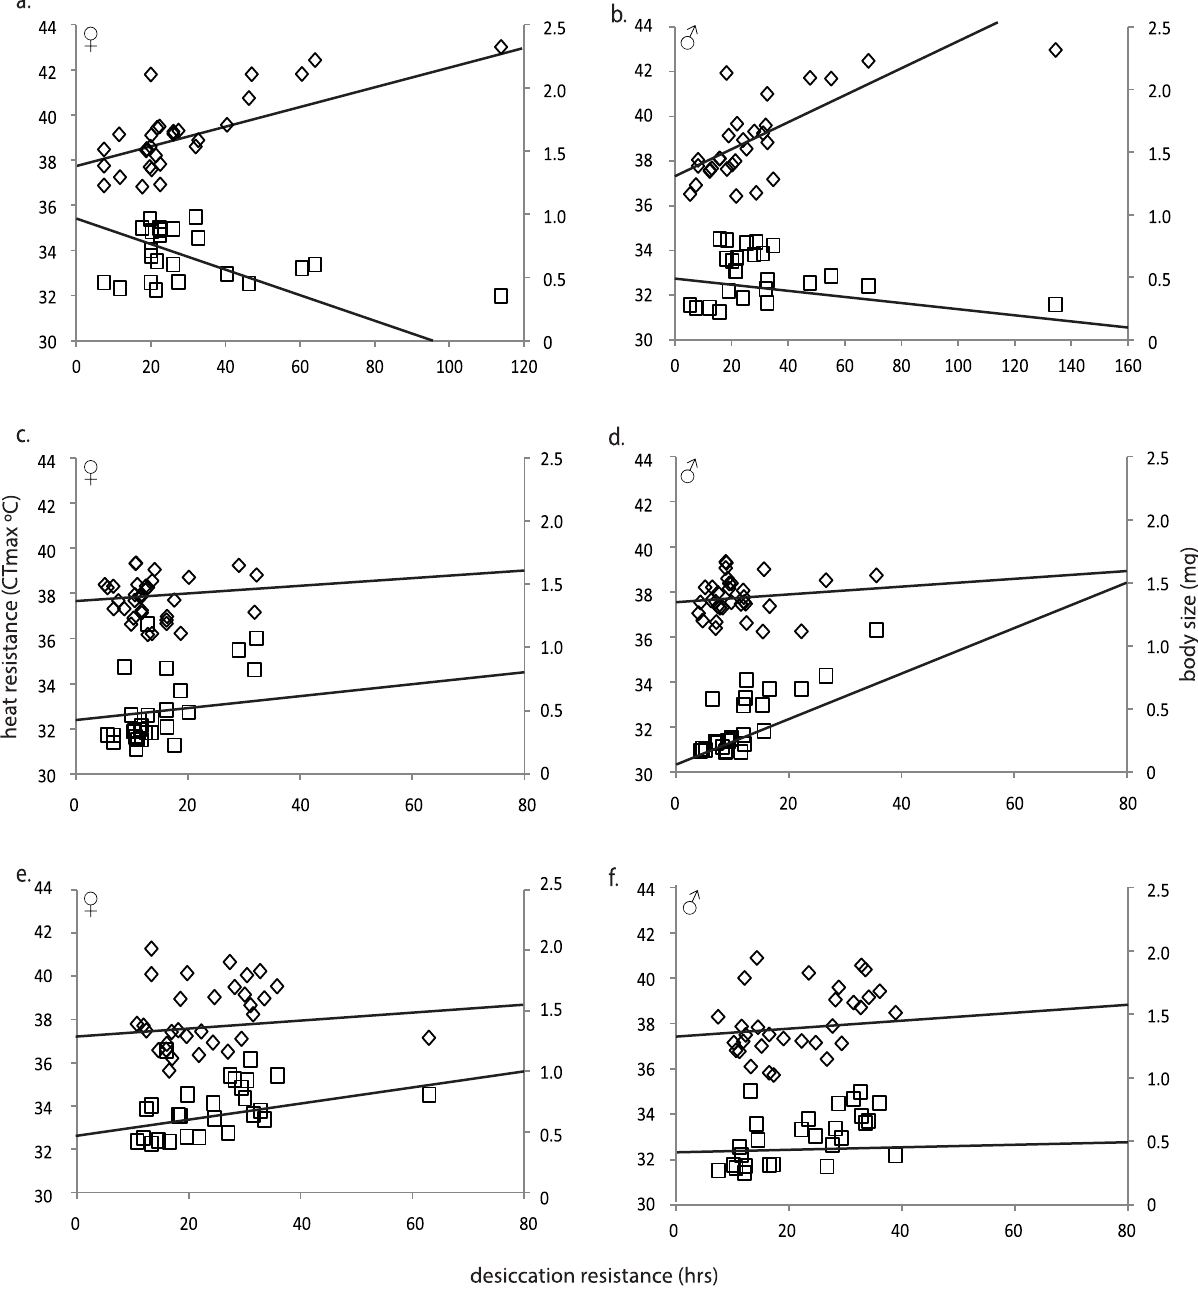
Figure 1. Correlations between traits across different environments. Correlations between the traits desiccation and heat resistance ( e ) and desiccation resistance and body size ( % ) for the three environments dry and hot (a–b), hot and wet (c–d) and cold (e–f). The solid line represents the correlation between traits following correction for phylogeny.